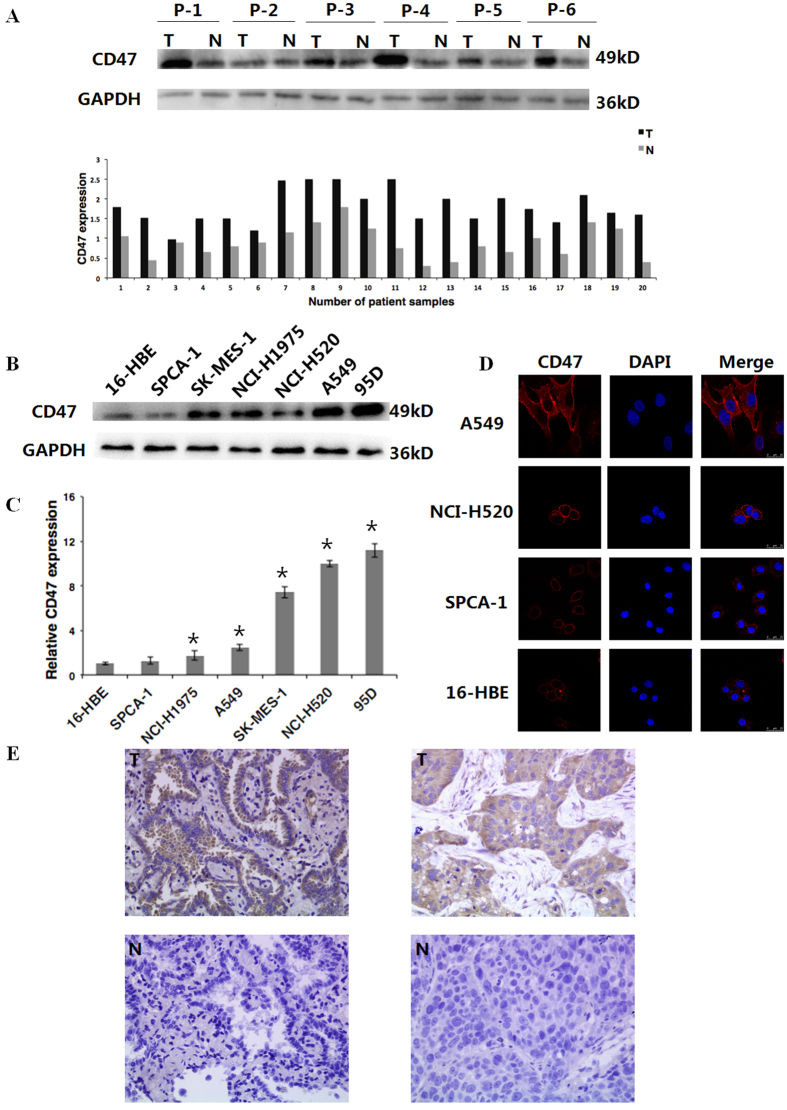
CD47 is overexpressed in NSCLC tissues and NSCLC cell lines.(A) Representative western blotting analysis of the expression of CD47 protein in paired NSCLC tissues (T) and adjacent non-tumor tissues (N), upper panel. GAPDH was used as a loading control. P, patient; Lowe panel, the quantification of CD47 expression (calculated as the ratio of CD47 signal intensity to GAPDH signal intensity) in 20 NSCLC tissues and matched adjacent non-tumor tissues. (B) Western blot analysis of CD47 expression in indicated NSCLC and normal bronchial epithelial cell lines. GAPDH was used as a loading control. (C) RT-qPCR on CD47 steady-state mRNA levels in the indicated NSCLC and normal bronchial epithelial cell lines. *P < 0.05, compared to 16-HBE cells. (D) Immunofluorescent staining for CD47 (red) in A549, NCI-H520, SPCA-1 and 16HBE cells. Nuclei were stained with DAPI (blue). (E) Representative immunohistochemical staining of CD47 (brown signal) in human NSCLC tissues (T) and matched adjacent non-tumor tissues (N) from a patient with squamous cell carcinoma (left) and a patient with adenocarcinoma (right); Magnification, × 400.